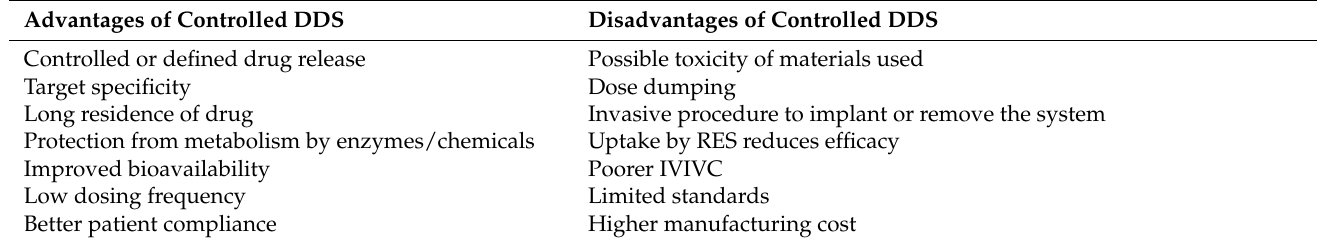
Table 4. Advantages and disadvantages of controlled drug delivery